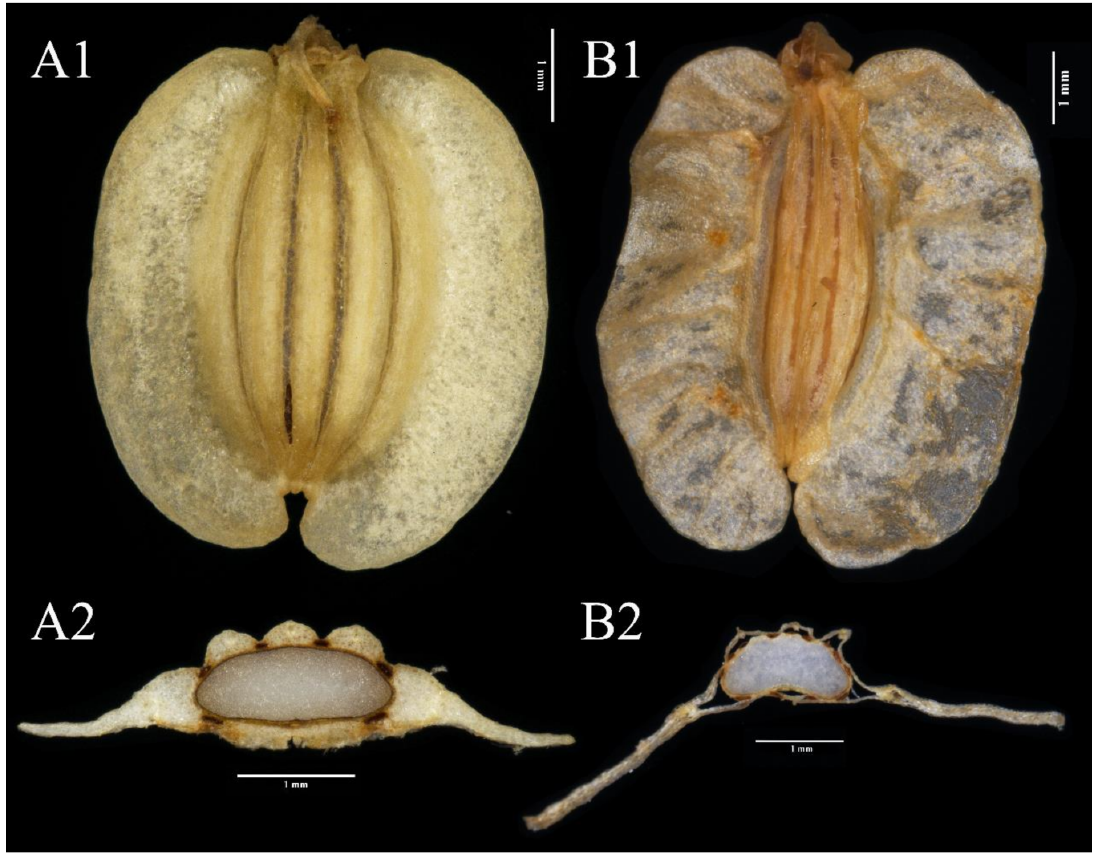
Figure 1. Fruit of ( A ) Angelica dahurica ; ( B ) Ostericum scaberulum . ( A1 , B1 ) Dorsal view of fruit; ( A2 , B2 ) Cross-section of